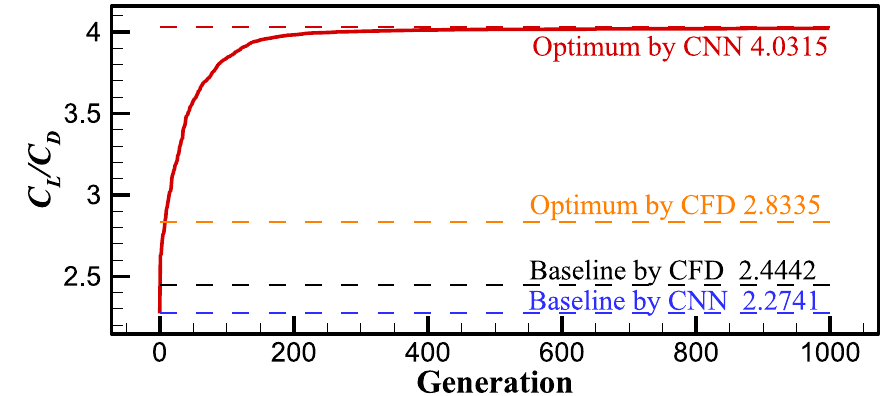
Fig. 25 Convergence history of aerodynamic shape optimization for the wing (optimization case 1)